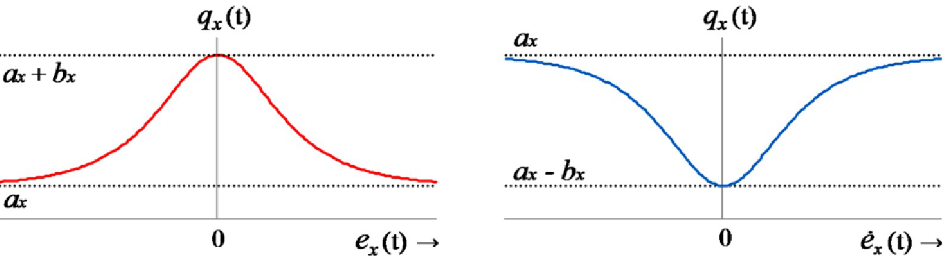
Fig 10. The waveforms of the proportional (left) and the differential (right) weight-adjusting functions.